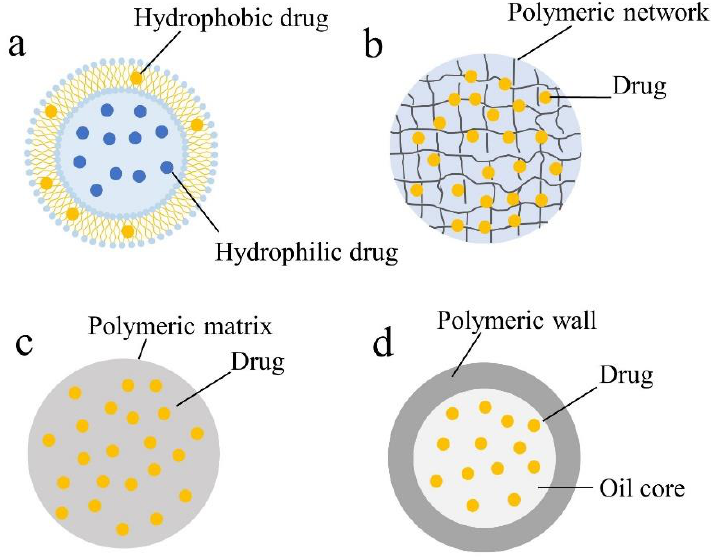
Figure 1. Schematic representation of different types of nanocarriers: ( a ) liposomes, ( b ) nanogels, ( c ) nanospheres, and ( d ) nanocapsules.